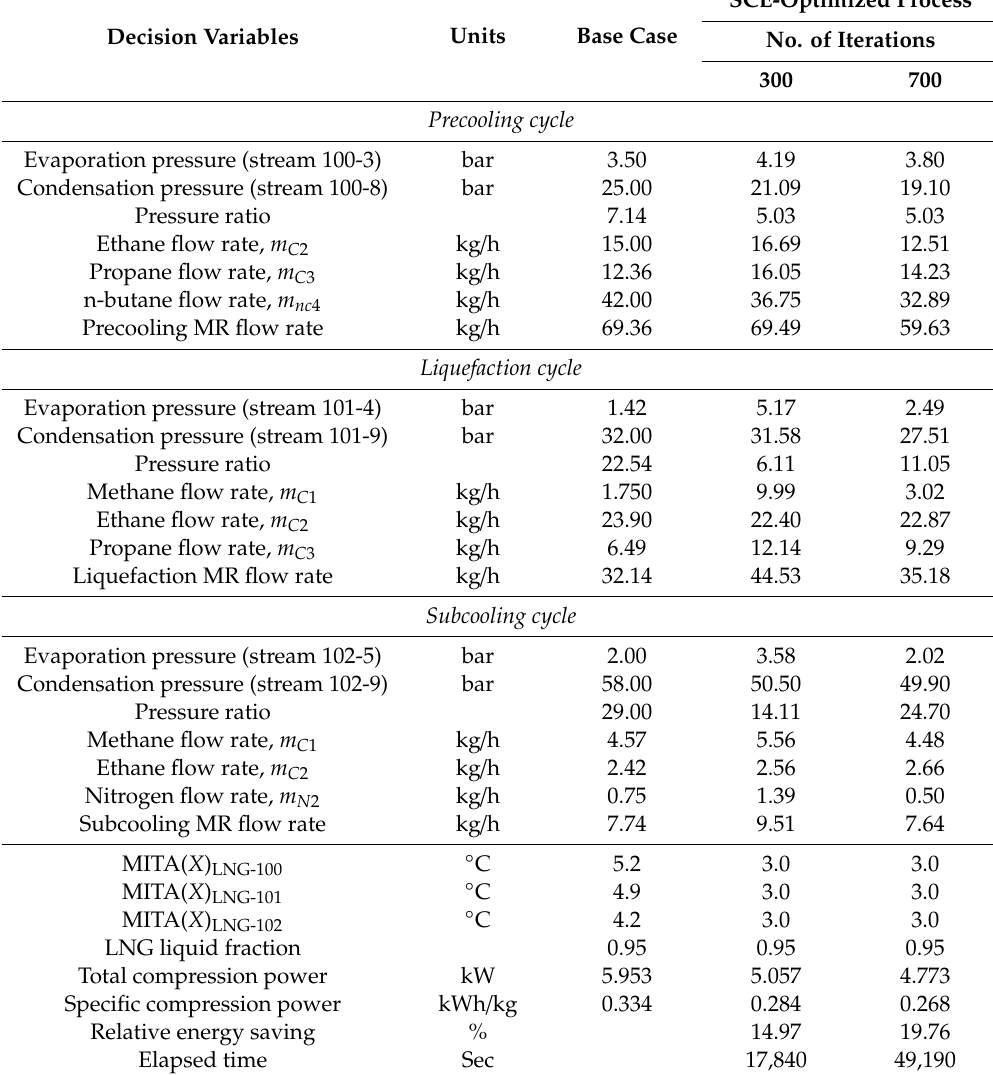
Table 3. Optimized values of decision variables and their impact of the objective